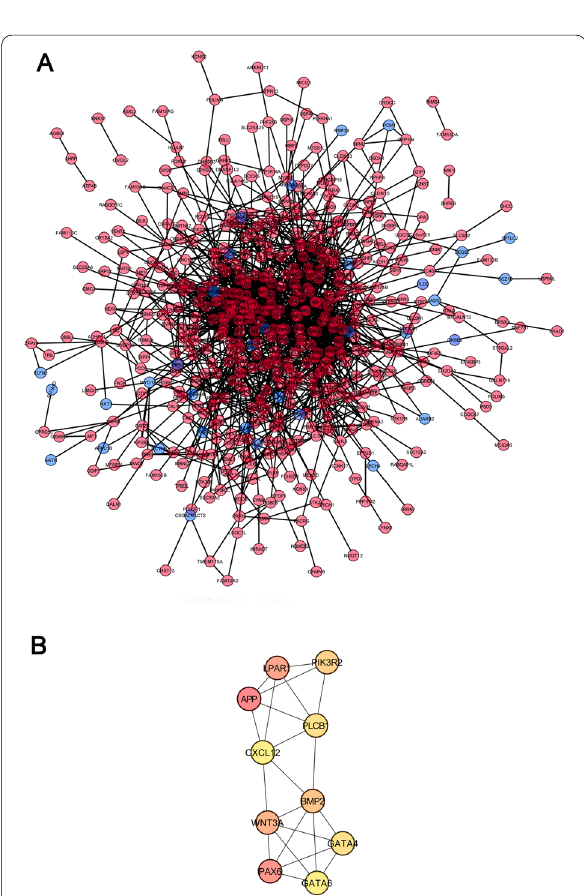
Fig. 4 Protein–protein interaction (PPI) network and modular analysis of the DMGs in periodontitis. A Using the STRING online database, a total of 630 nodes (red represents hypo-methylated genes, and blue represents hyper-methylated genes) and 1790 interactions were identified in the DMG PPI network. B Top 10 genes in network string interactions by Degree method